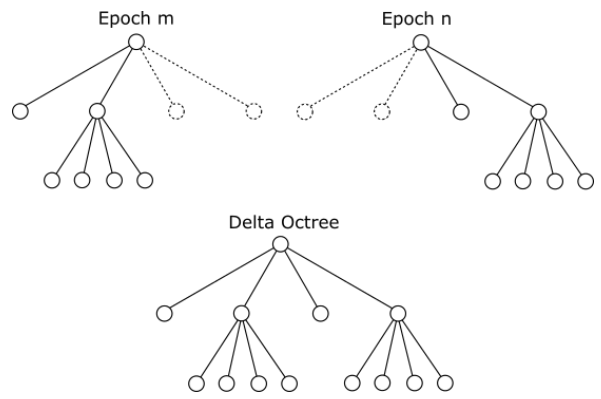
Figure 4. An example for a Delta Octree (bottom), derived from two Gaussian Occupancy Octrees (top left and